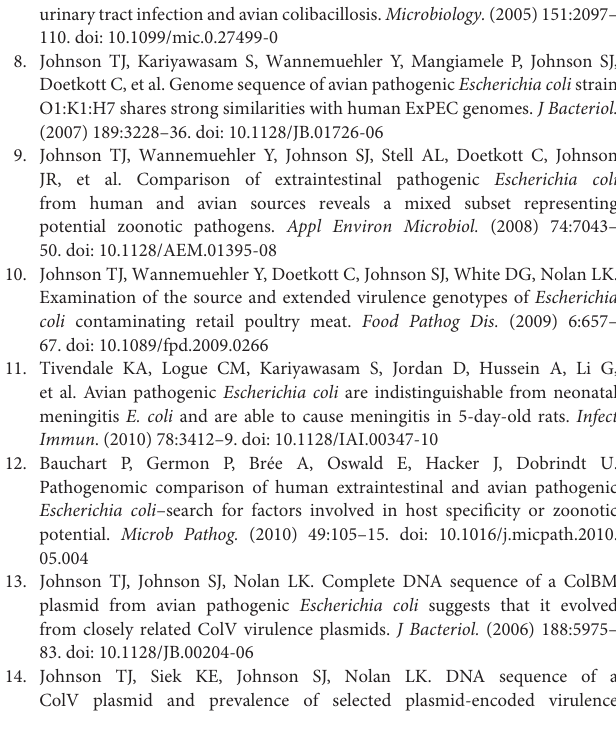
Supplementary Figure 1 | Unweighted pair-group method with arithmetic clustering (UPGMA) dendrogram based on data from virulence-associated gene profiles of Escherichia coli strains. Based on a similarity index of 63% (blue line), 5 majors clusters (I-V) were found. The colors mean as follow: : Yolk sac infection strains; : Clisepticemia strains; : Fecal strains; : phlogroup F; : phlogroup A; : phlogroup B2; : phlogroup E; : phylogroup B1; : phlogroup C; ERIC: Enterobacterial repetitive intergenic consensus. Blue boxes indicate presence of virulence-associated gene. ∗ : O1; ∗∗ : O2; ∗ ∗ ∗ : O78. Supplementary Figure 2 | Unweighted pair-group method with arithmetic clustering (UPGMA) dendrogram based on data from antimicrobial resistance phenotype and virulence-associated gene profiles of Escherichia coli strains. Based on a similarity index of 70% (black line), 9 majors clusters (A-I) were found. The colors mean as follow: : Yolk sac infection strains; : Clisepticemia strains; : Fecal strains; : phlogroup F; : phlogroup A; : phlogroup B2; : phlogroup E; : phylogroup B1; : phlogroup C; ERIC: Enterobacterial repetitive intergenic consensus. ∗ : O1; ∗∗ : O2; ∗ ∗ ∗ : O78. Supplementary Table 1 | Antimicrobial resistance among avian Escherichia coli strains isolated from samples of diseased birds and feces of healthy chickens. Supplementary Table 2 | The P values of associations between different traits of avian Escherichia coli